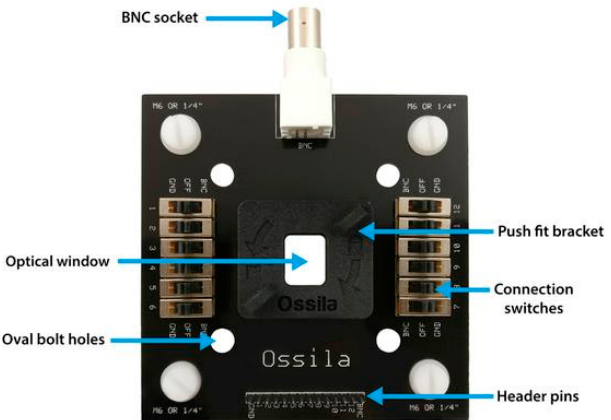
Figure 14. The test board used for making electrical connections to the photovoltaic devices. The substrate is placed in the center of the board and the cell which is to be characterized is selected using the respective switches. Image remains the copyright of Ossila Ltd. Taken with permission from Ossila Ltd. [29].